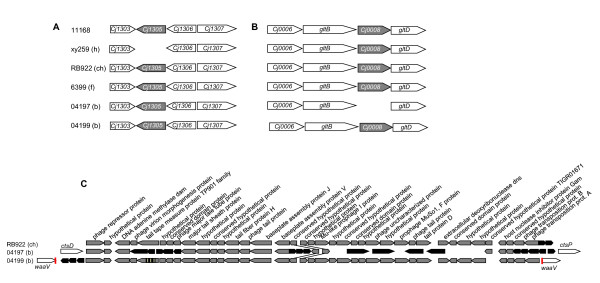
Examples for gene loss or gain in complete genome sequences of five ST-21 C. jejuni strains. (A) Loss of ortholog to gene Cj1305, which belongs to the 617 family located in the flagellin glycosylation gene cluster, in the human strain xy259. (B) Loss of ortholog to gene Cj0008 in 04197 nestled in between putative pyridine nucleotide-disulphide oxidoreductase large subunit gene gltB and small subunit gene gltD. (C) Common phage insertion in three ST-21 strains. The flanking genes of the phage insertion site are indicated by white arrows in the strains 04197 and 04199. Grey arrows show phage genes similar in all strains, black arrows indicate unique phage genes. The phage is related to CJIE1 in the whole genome sequence of C. jejuni RM1221 [20].